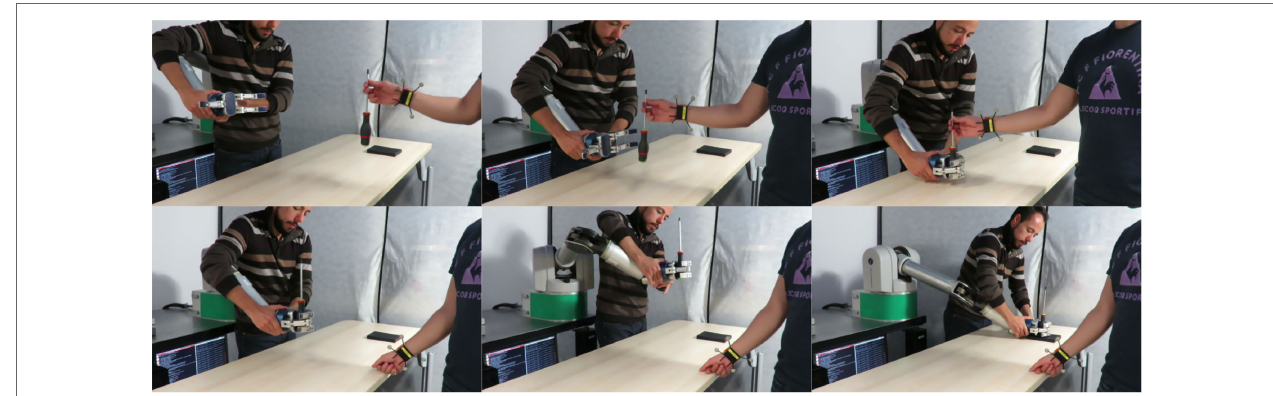
FIGURE 4 | Experimental setting of the handover and transportation task . The teacher on the left demonstrates the skill to the robot, while the person on the right is the collaborator. After learning, the robot reproduces the collaborative behavior as demonstrated by the teacher. Top: first phase of the demonstration in which the robot reaches for an object (a screwdriver in this setup) that is delivered by the user. The hand position is tracked using optical markers. Bottom: second phase of the demonstration showing the transportation of the object toward its final location (black area).